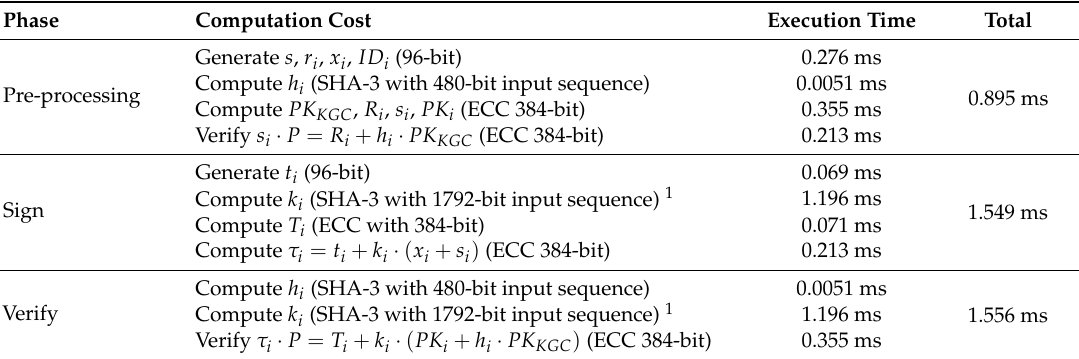
Table 5. The computation cost of our proposed certificateless signature scheme implemented on the Raspberry PI 2 with Condition (2).